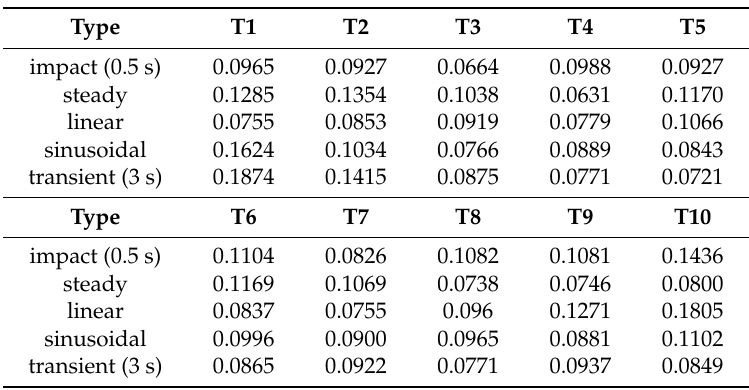
Table 5. Training sample data for load identification in BP neural network.